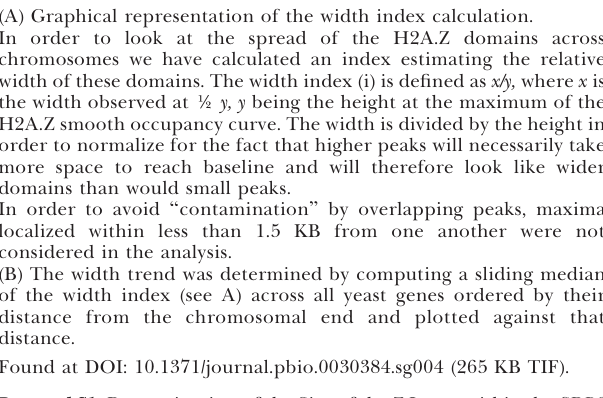
Found at DOI: 10.1371/journal.pbio.0030384.sg001 (962 KB TIF). Figure S2. Q-PCR Analysis of H2A.Z ChIP Experiments (A) The locus including the PRS2, UBC6, AST2, and RPS8B genes is drawn to scale, and the positions of the PCR probes used to monitor H2A.Z occupancy are shown as black bars. The H2A.Z/H2B ratios are shown by gray bars. (B) Same as in (A) but for the GIT1 locus, a gene contained within an HZAD domain. (C) Same as in (A) and (B) but for the ACT1 locus. The H2B/input ratio is also shown as white bars. In each panel, the probe with the lowest ratio was set to ‘‘ 1. ’’ Found at DOI: 10.1371/journal.pbio.0030384.sg002 (763 KB TIF). Figure S3. H2A.Z Occupancy at HZAD10 (A) The raw (green) and smoothed (red) H2A.Z/H2B ratios are shown across a 15-KB region from Chromosome IX containing HZAD10 (gray shaded box). The genes in that region are shown in blue. (B) Same as in (A) but for a non-HZAD region from Chromosome III. Found at DOI: 10.1371/journal.pbio.0030384.sg003 (749 KB TIF). Figure S4. Z Loci Are Wider around Telomeres